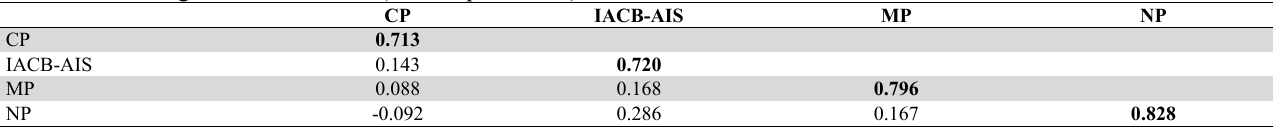
Correlations among Latent Constructs (AVE Square Root)